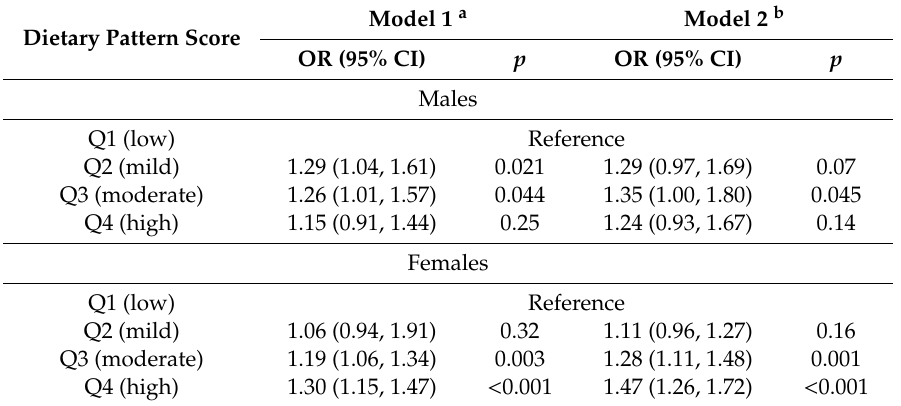
Table 3. Association between quartiles of inflammatory dietary pattern scores and anemia. Model 1 a Model 2 Dietary Pattern Score